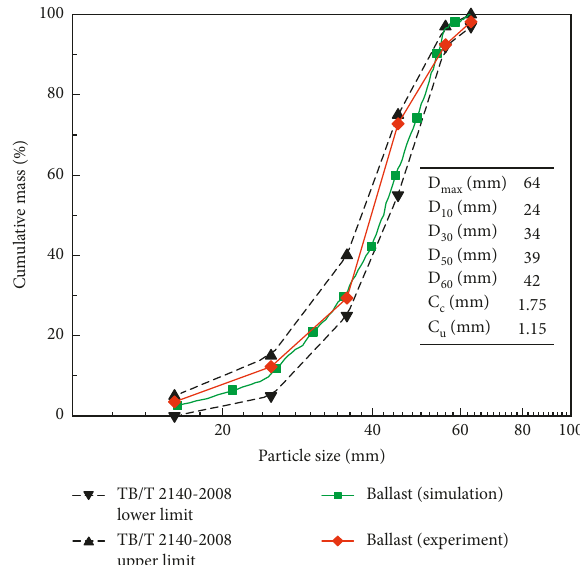
Figure 1: Particle-size distributions in simulations and experiments.